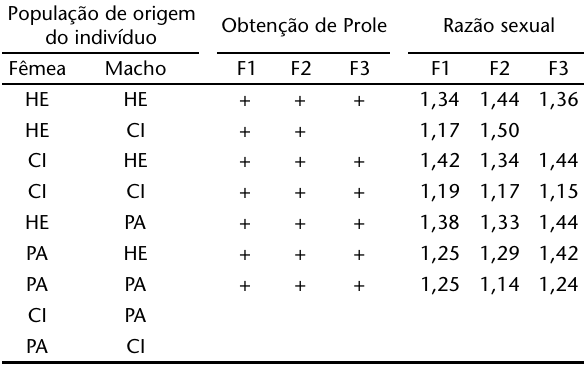
Tabela IX. Intercruzamento de indivíduos de E . banksi oriundos dos hospedeiros H . brasiliensis (HE), C . sinensis (CI) e P . aquatica (PA). Utilizou-se como substrato folhas do hospedeiro da fêmea. Obtenção de prole em três gerações e respectiva razão sexual